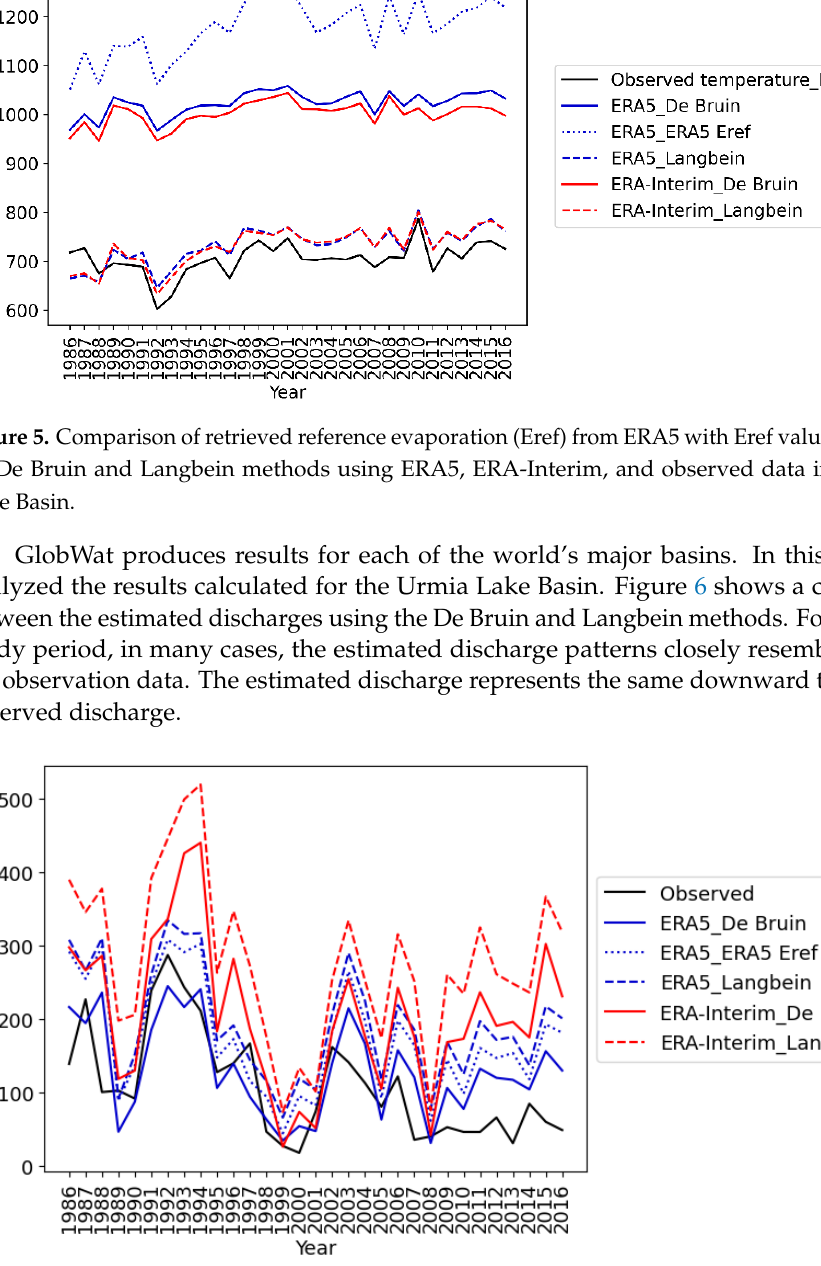
Figure 7. Taylor diagram, RMSE, and NSE comparing the estimated discharge by the GlobWat model using different weather datasets and Eref methods against the observed data in three periods over the Urmia Lake Basin. From 2006 to 2016, the model did not perform as well as it did from 1986 to 2006. This could be due to the model ’ s sensitivity to precipitation, as the differences between the precipitation datasets and the observed precipitation were larger from 2006 to 2016 than